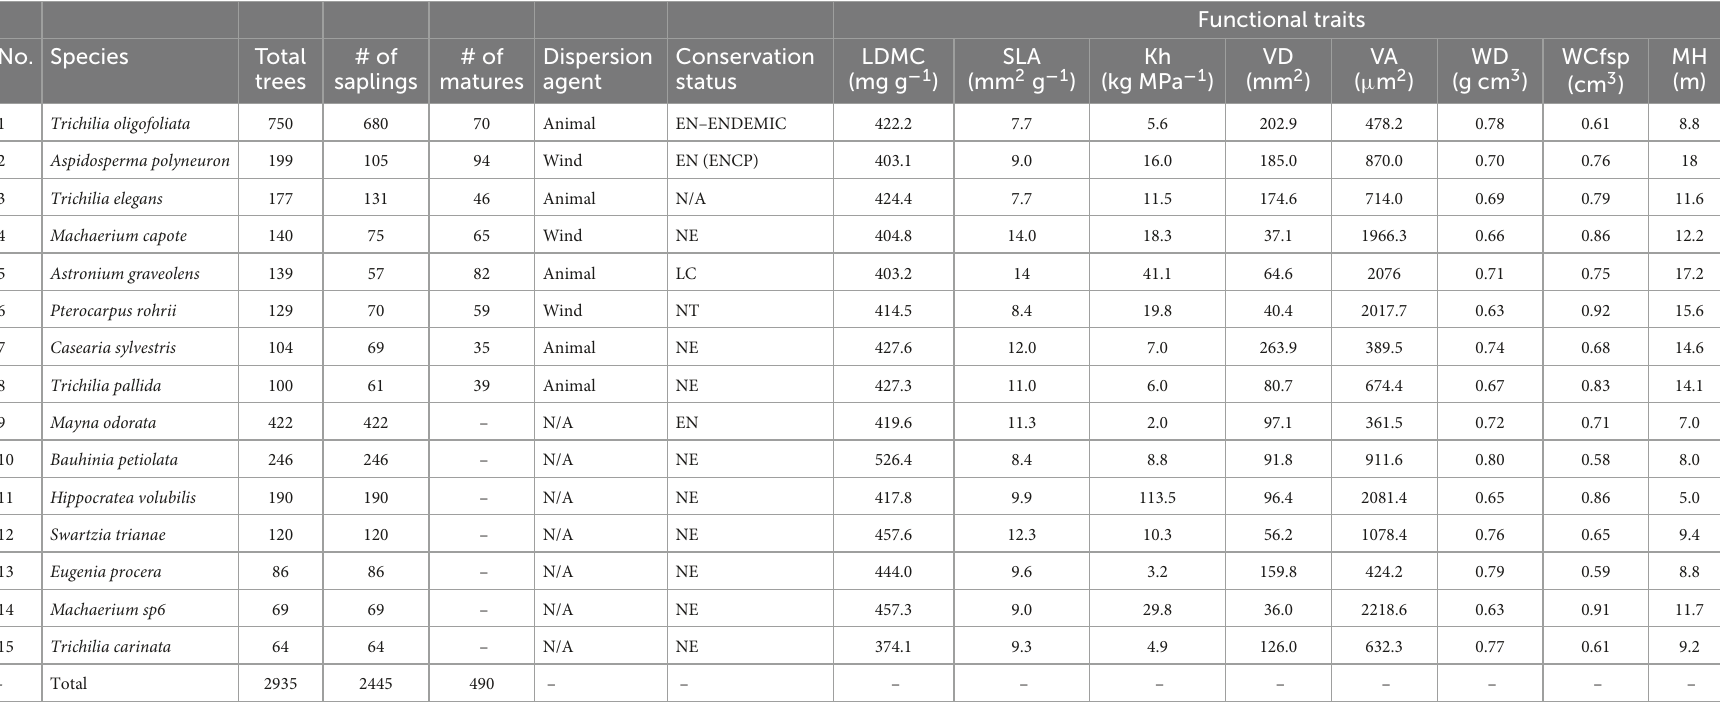
TABLE 1 Characteristics of the selected tree species and their hydraulic functional trait values.